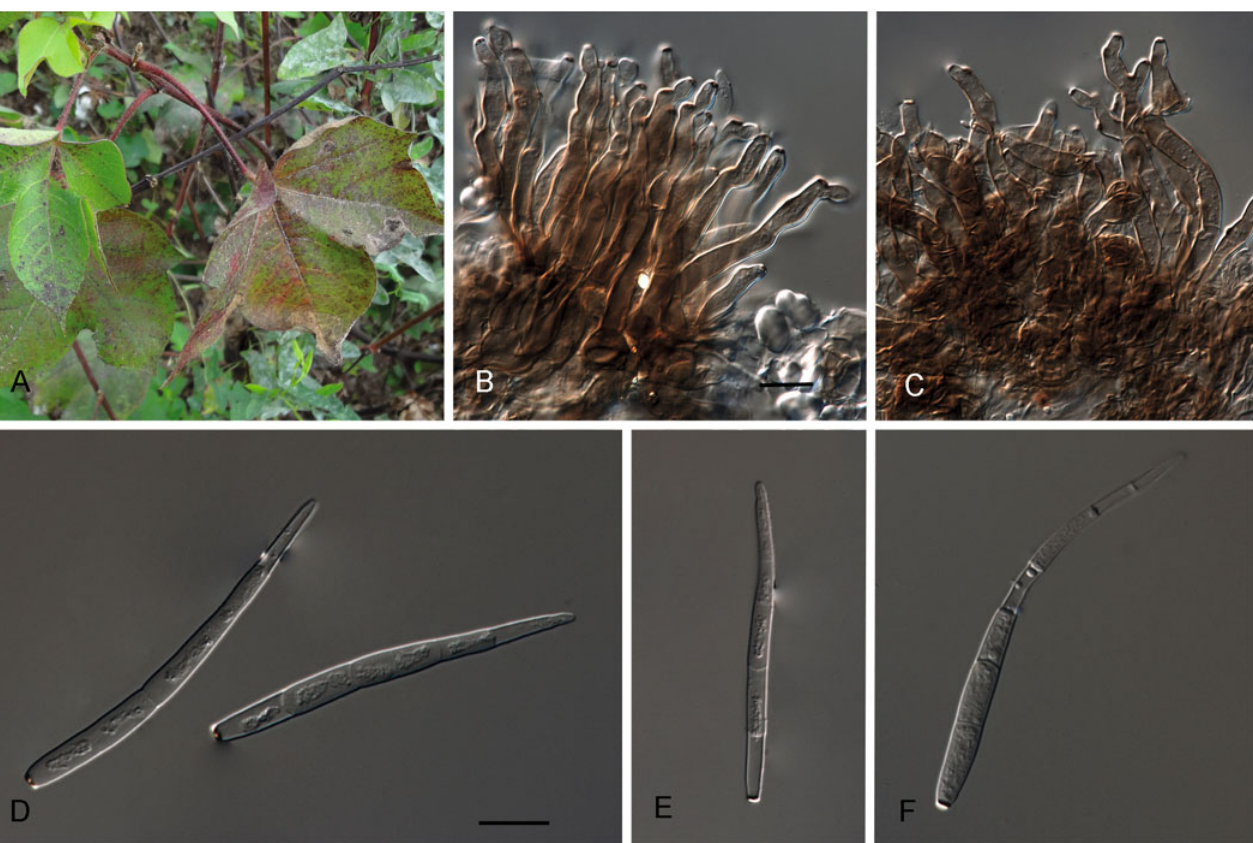
Fig. 7. Cercospora gamsiana (cid:2)(cid:24)%=%(cid:2)*9"+"(cid:2)(cid:134)(cid:2)%’7(cid:2)!99"$*(cid:27)(cid:28)(cid:2) A. (cid:2)S(cid:13)(cid:9)(cid:26)(cid:2)(cid:7)(cid:18)(cid:4)(cid:8)(cid:7)(cid:28)(cid:2) B–C. (cid:2)2(cid:9)(cid:7)(cid:19)(cid:11)(cid:19)(cid:5)(cid:23)(cid:9)(cid:8)(cid:13)(cid:2)(cid:19)(cid:4)(cid:17)(cid:11)(cid:21)(cid:11)(cid:4)(cid:18)(cid:14)(cid:4)(cid:10)(cid:13)(cid:7)(cid:28)(cid:2) D–H. (cid:2)%(cid:4)(cid:17)(cid:11)(cid:21)(cid:11)(cid:9)(cid:28)(cid:2)’(cid:9)(cid:10)(cid:7)(cid:2)(cid:134)(cid:2)!+(cid:2)_(cid:6)(cid:28)